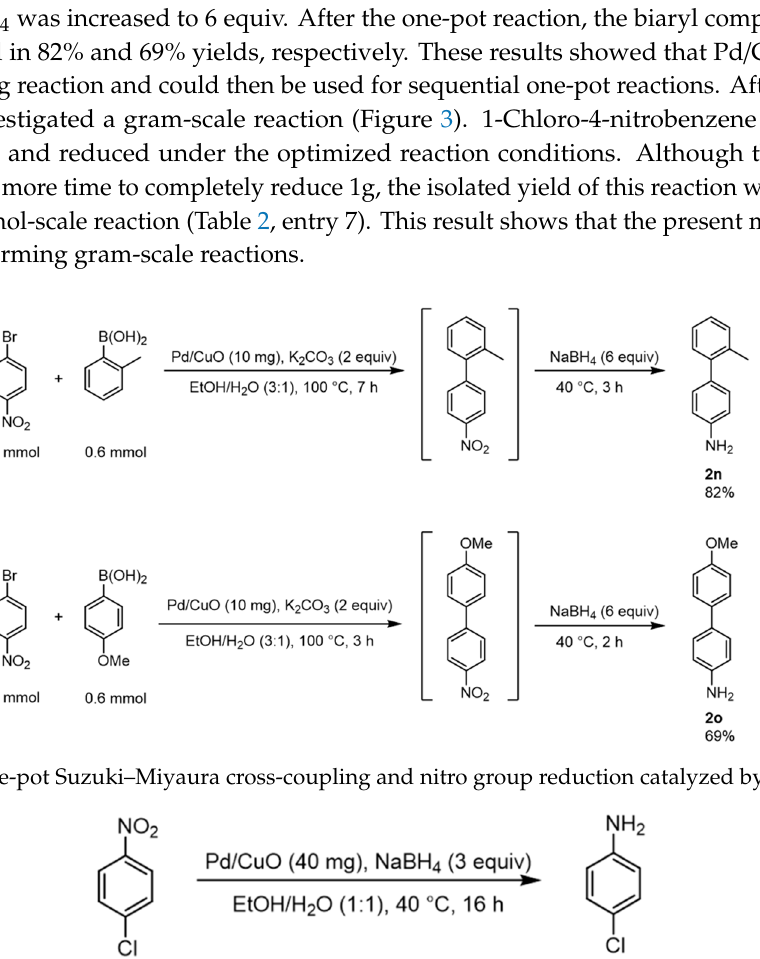
Table 3. Reusability of Pd/CuO a .